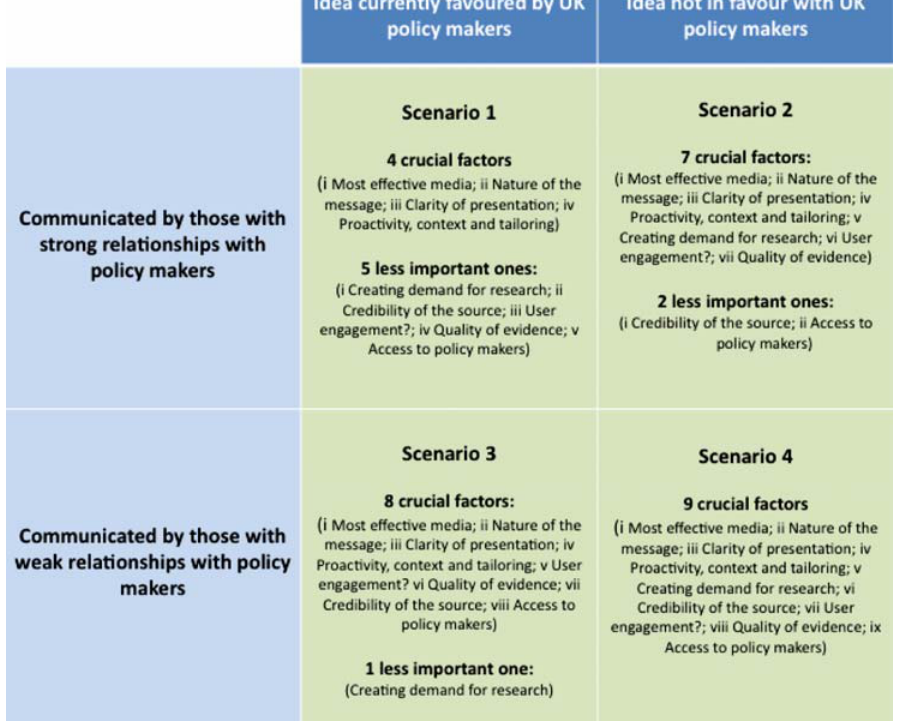
Figure 1. Factors that affect the adoption of research (from Brown